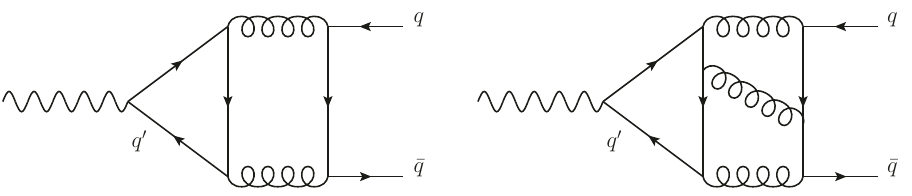
Figure 9 . Example of Feynman diagrams contributing to the ‘singlet’ contribution at two and three